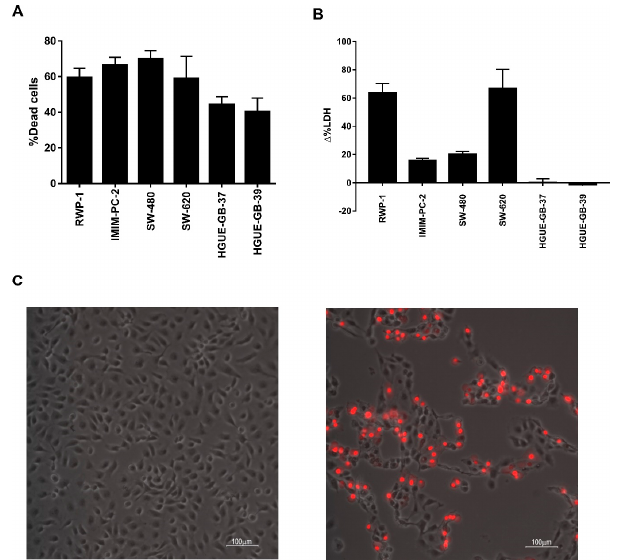
Figure 7. CLytA-DAAO plasmatic membrane rupture. ( A ) RWP-1 and IMIM-PC-2 pancreatic adenocarcinoma cell lines, SW-480 and SW-620 colon carcinoma cell lines, and HGUE-GB-37 and HGUE-GB-39 glioblastoma cell lines were treated with 2 U mL − 1 CLytA-DAAO, and 1 mM D-Ala for 24 h and viability was determined by flow cytometry. Data represent the mean ± SEM of the percentage of dead cells with respect to control, with n ≥ 3. ( B ) RWP-1 and IMIM-PC-2 pancreatic adenocarcinoma cell lines, SW-480 and SW-620 colon carcinoma cell lines, and HGUE-GB-37 and HGUE-GB-39 glioblastoma cell lines were treated with 2 U mL − 1 CLytA-DAAO, and 1 mM D-Ala for 24 h and extracellular LDH activity was measured. Data represent the mean ± SEM of the percentage of change in extracellular detected LDH activity between the treated cells and the control untreated cells, with n ≥ 3. ( C ) IMIM-PC-2 pancreatic adenocarcinoma cell line was treated with 2 U mL − 1 CLytA-DAAO, and 1 mM D-Ala for 6 h, and propidium iodide uptake was determined by microscopy. The left panel shows control cells and the right panel shows treated